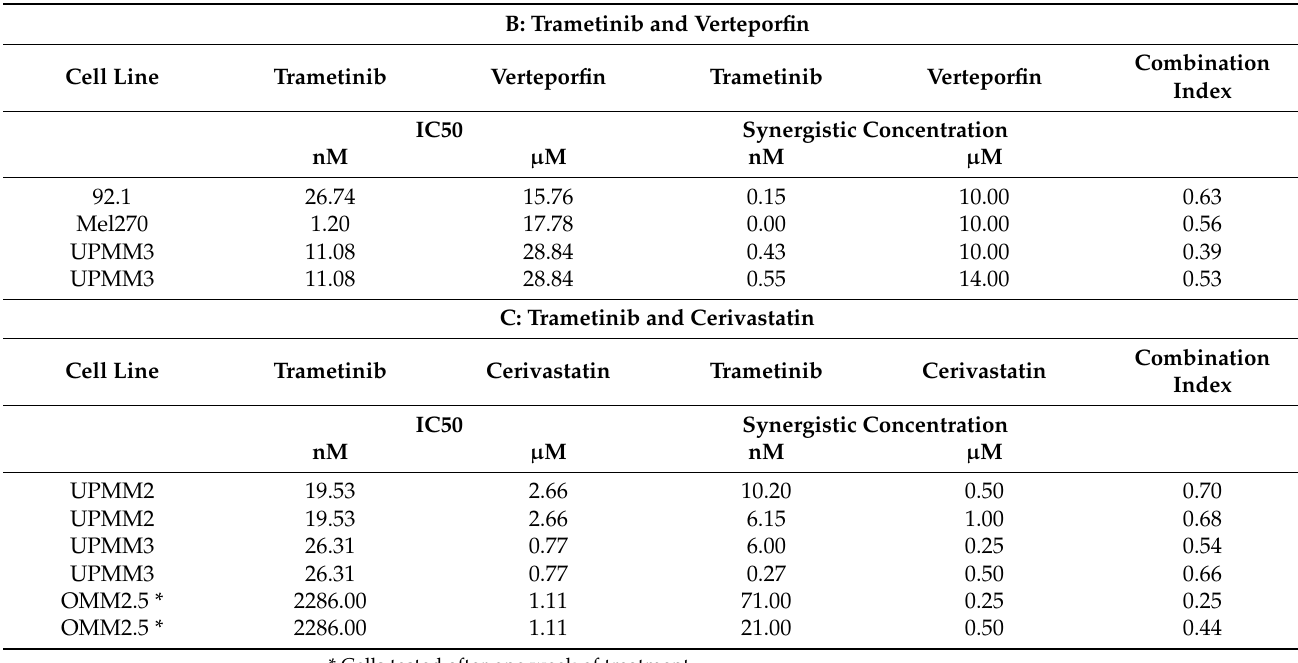
Table 3. Cont. B: Trametinib and Verteporfin